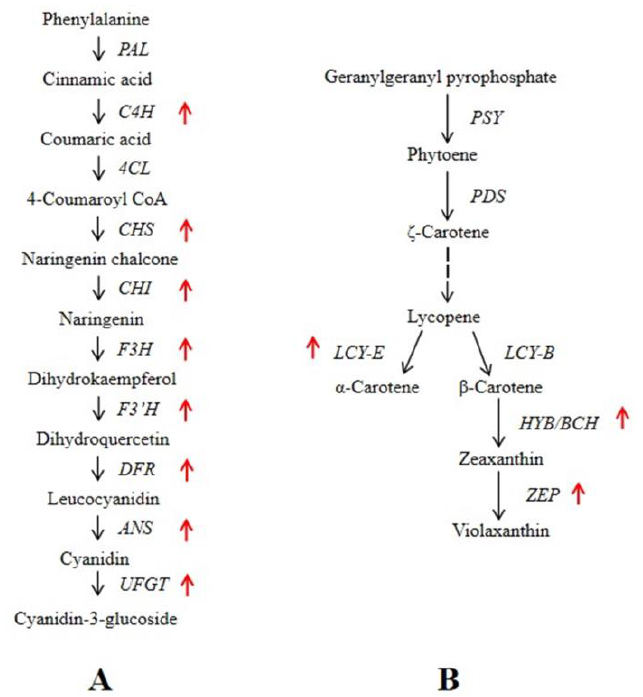
Figure 6. Relative pathway and enzymes involved in anthocyanin ( A ) and carotenoid ( B ) biosyn- thesis of P. avium fruit. The up arrow in the anthocyanin pathway indicates JNH S4 vs. CY S4 upregulated. The up arrow in the carotenoid pathway indicates CY S1 vs. JNH S1 upregulated.